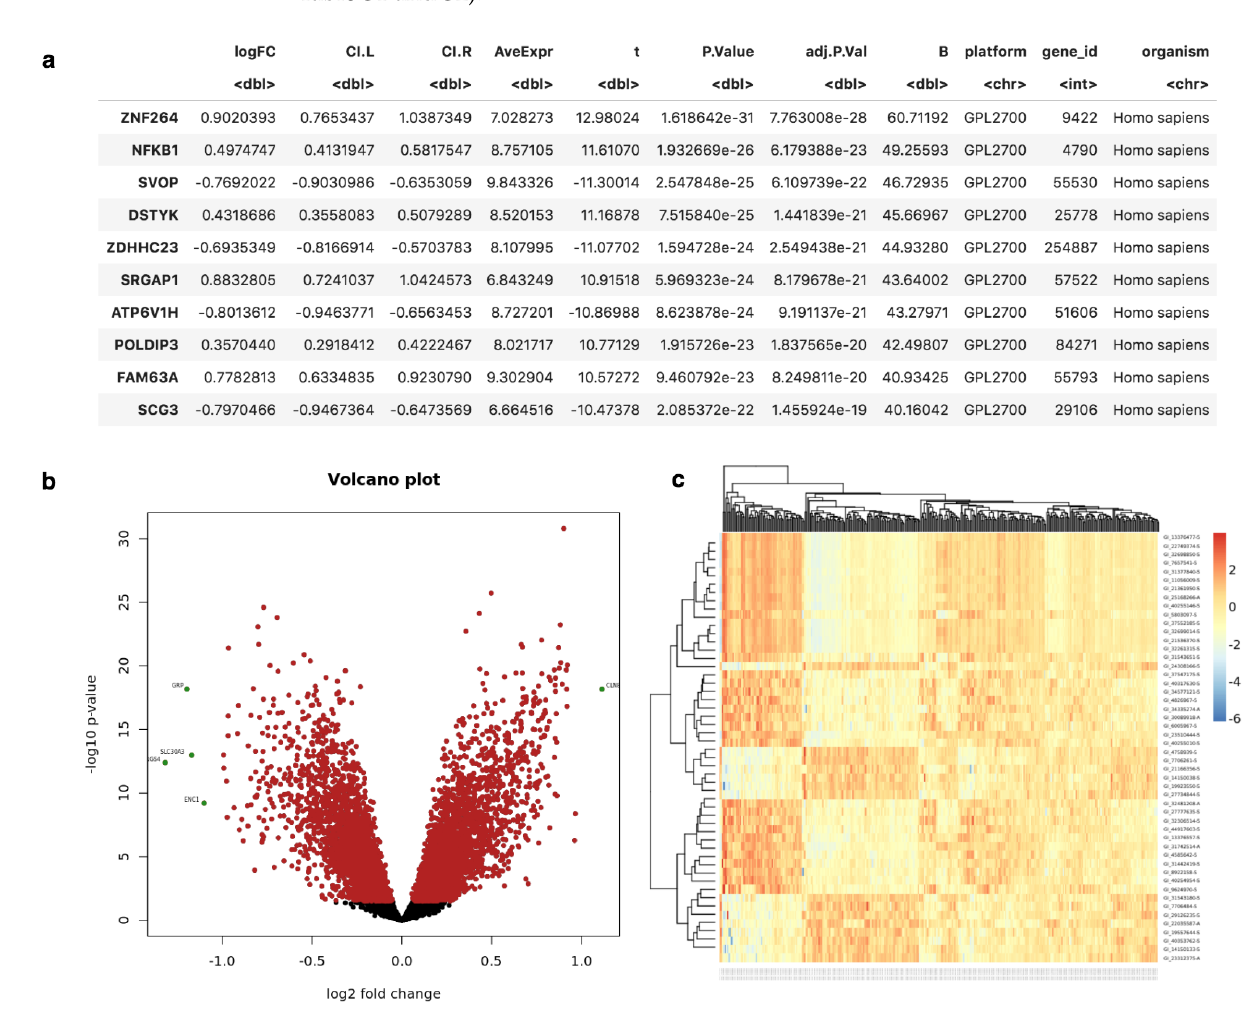
Figure 6. Results obtained from Microarray DE analysis. ( a ) candidate genes in tabular format. ( b , c ) Volcano and Heatmap plots highlighting top DE